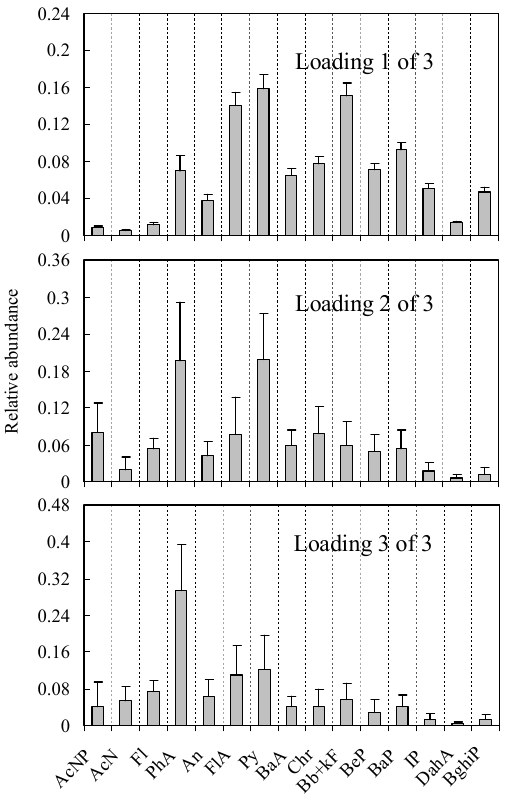
Figure 3. Factor loading plots of sediment PAH three-source factor analysis solutions with error bars representing the standard deviation of the mean derived from the Monte Carlo uncertainty analysis.